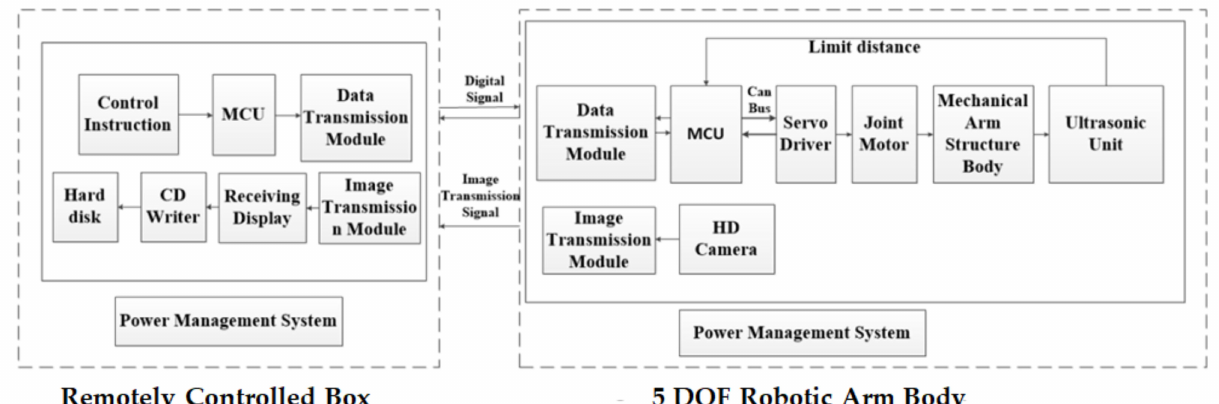
Figure 11. EOD Robot control system